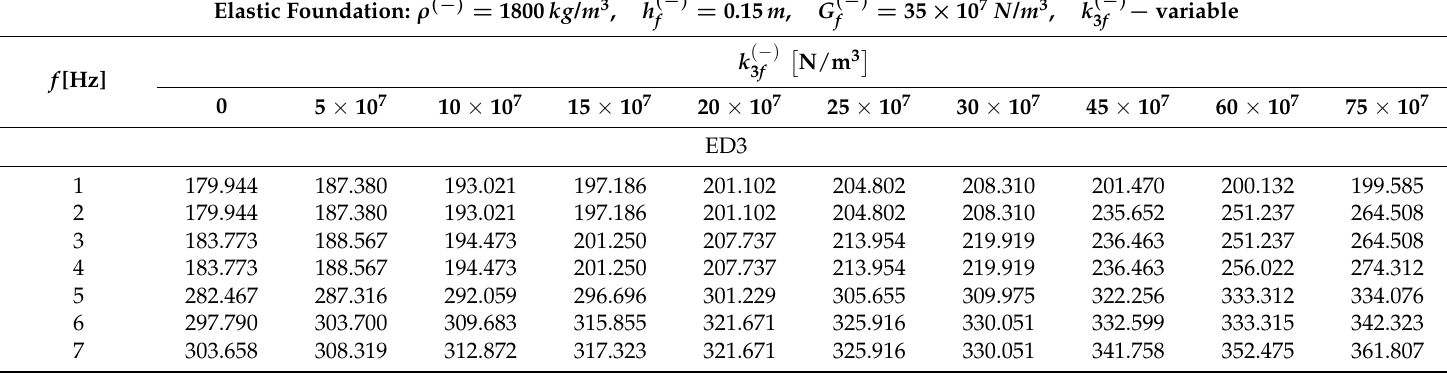
Table 7. First seven natural frequency variations of a CFCF cylindrical surface (Figure 4b) reinforced by CNTs distributed as in Figure 5b for the different theories. The mass fraction was w r = 0.25, and the agglomeration parameters µ 1 = 0.5 and µ 2 = 0.75. The Chebyshev-Gauss-Lobatto grid distribution was employed, with I N = I M =